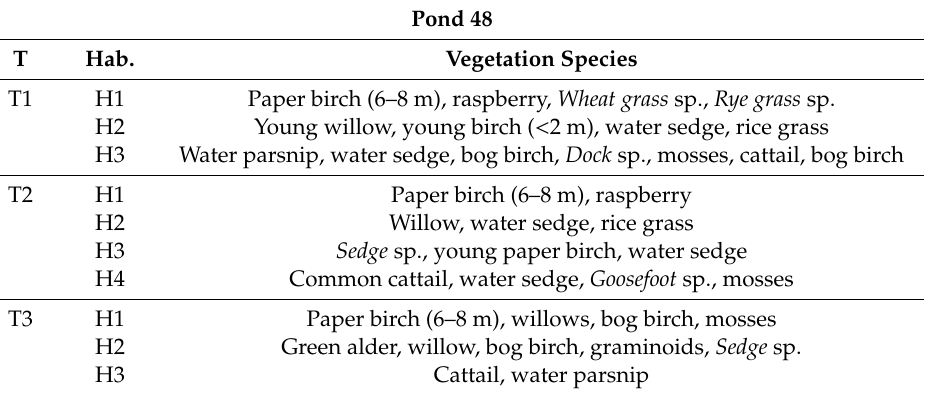
Table 7. Riparian vegetation species composition for Pond 42 (refer to Figure 11a for transect and derived habitat locations).